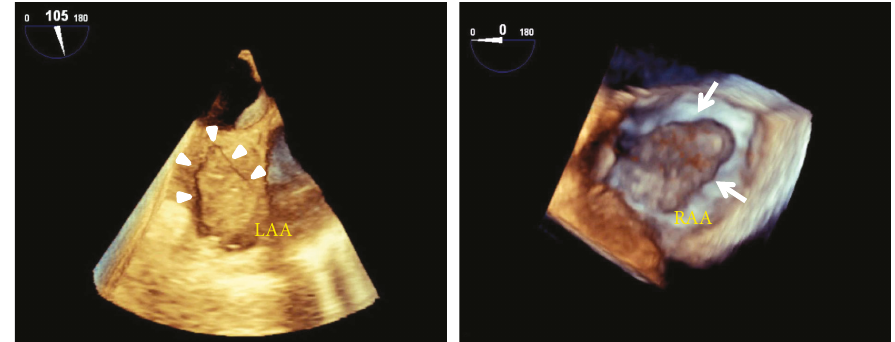
Figure 4: Three-dimensional transesophageal echocardiographic images of the left (arrow heads) and right (arrows) atrial appendage thrombi. Abbreviations are the same as in Figure